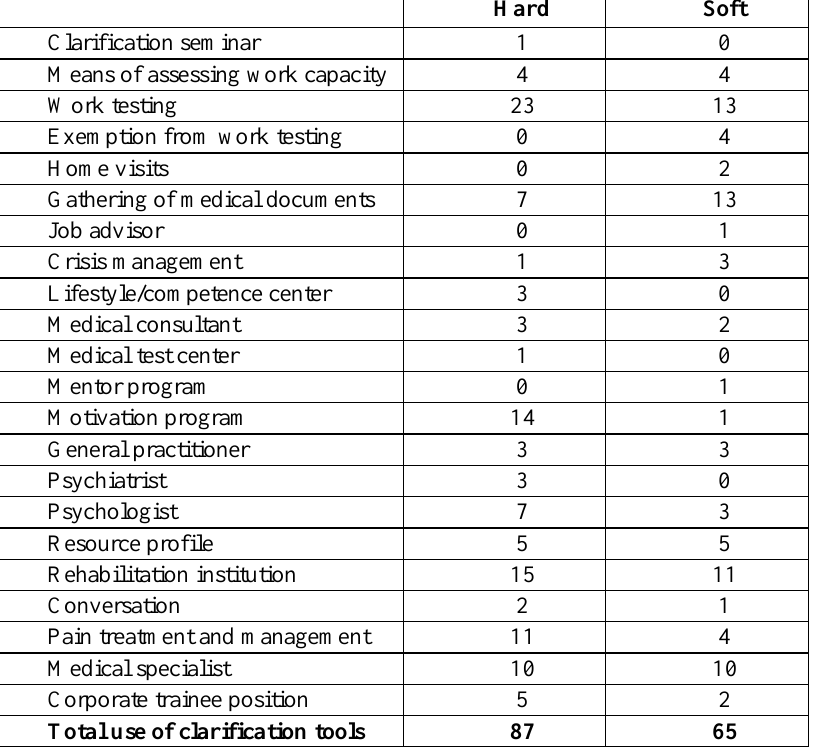
Caseworkers’ use of clarification tools Hard Soft Clarification seminar 1